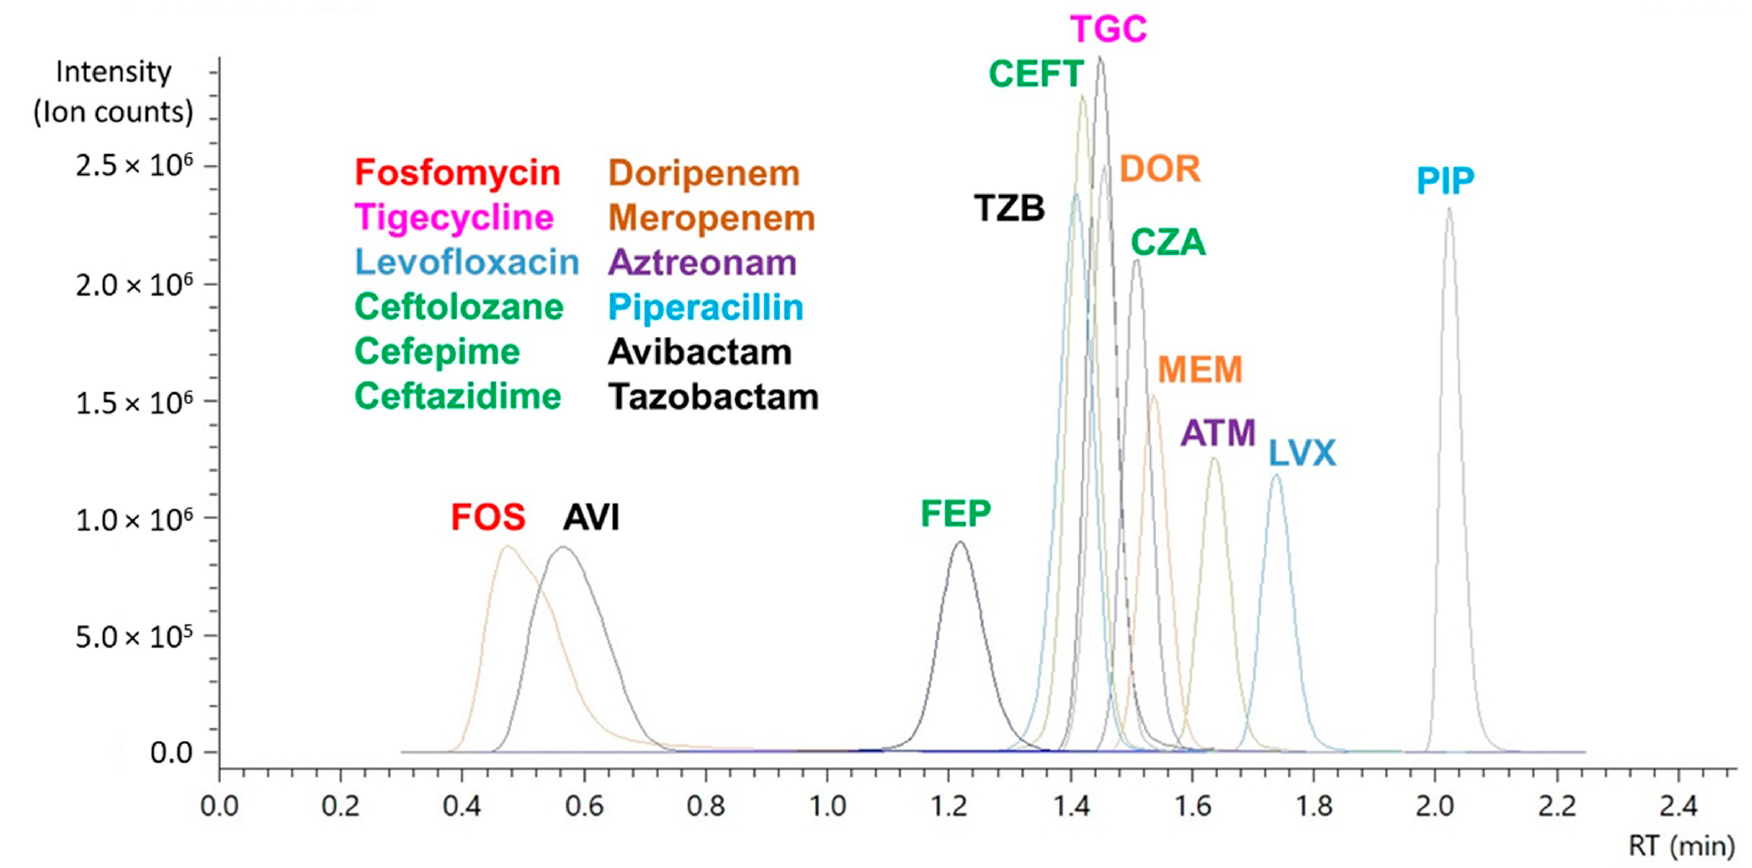
Figure 2. Chromatogram of each antibiotic compound and β -lactamase inhibitor (depicted in black) using a 2.1 × 50 mm C8 column.